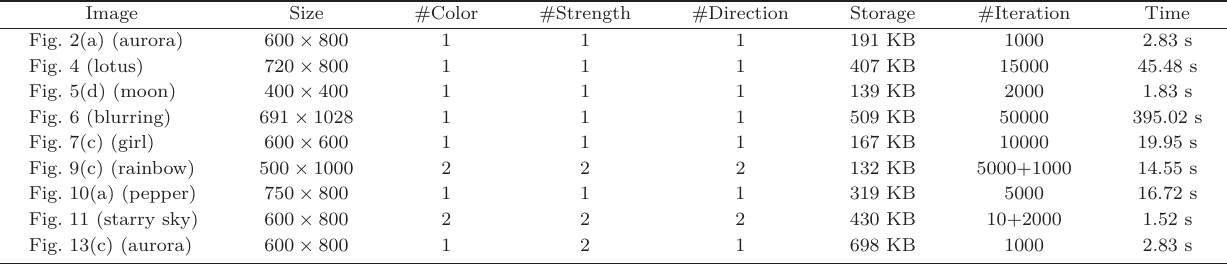
Table 1 Storage and timing for the DCC model, showing storage used, number of iterations used, and time taken. For the rainbow image, 5000 iterations were used for the rainbow and 1000 for the cloud. For the starry sky image, 10 iterations were used for the stars and 2000 for the moon, and iteration count of cloud is 1000 Image Size